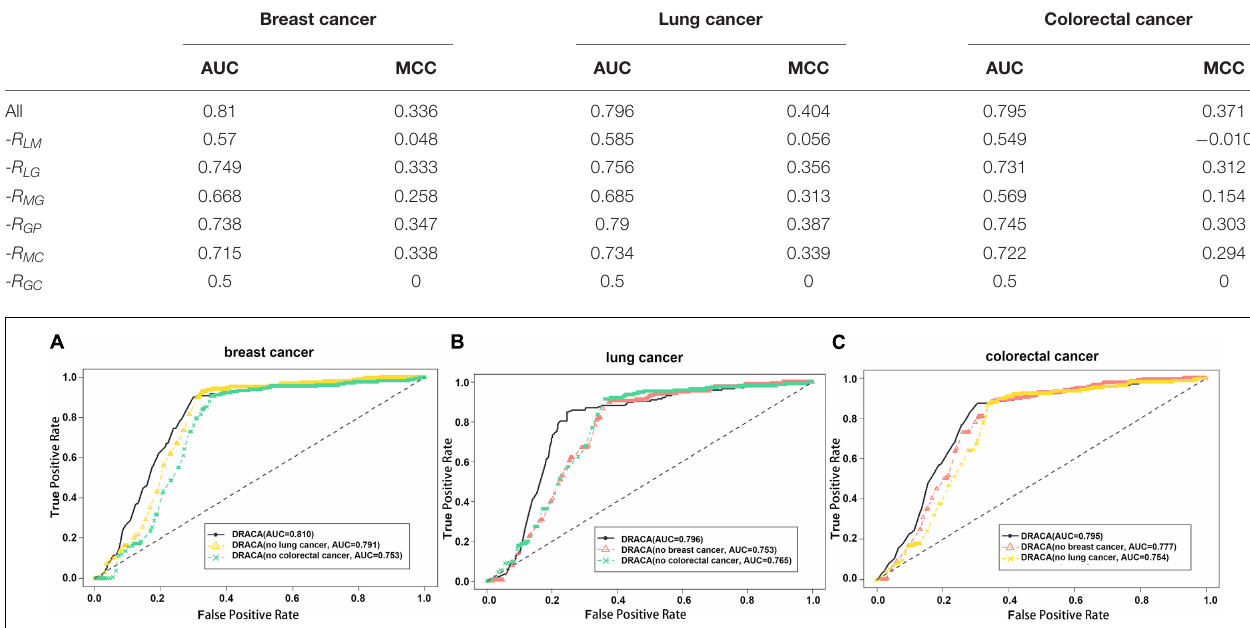
FIGURE 2 | The influences of cancer types in detecting lncRNA cancer association (DRACA) prediction. The black lines represent the ROC curves of DRACA without removing any features in predicting associations between lncRNA and cancers. The red and green lines denote the ROC curves of DRACA removing cancer information. (A) The ROC curves to show the influences of removing lung cancer information (yellow curve) or removing colorectal cancer information (green curve) in predicting breast cancer associated lncRNAs; (B) The ROC curves to show the influences of removing breast cancer (red curve) or removing colorectal cancer information (green curve) in predicting lung cancer associated lncRNAs; (C) The ROC curves to show the influences of removing breast cancer information (red curve) or lung cancer (yellow curve) in predicting colorectal cancer associated